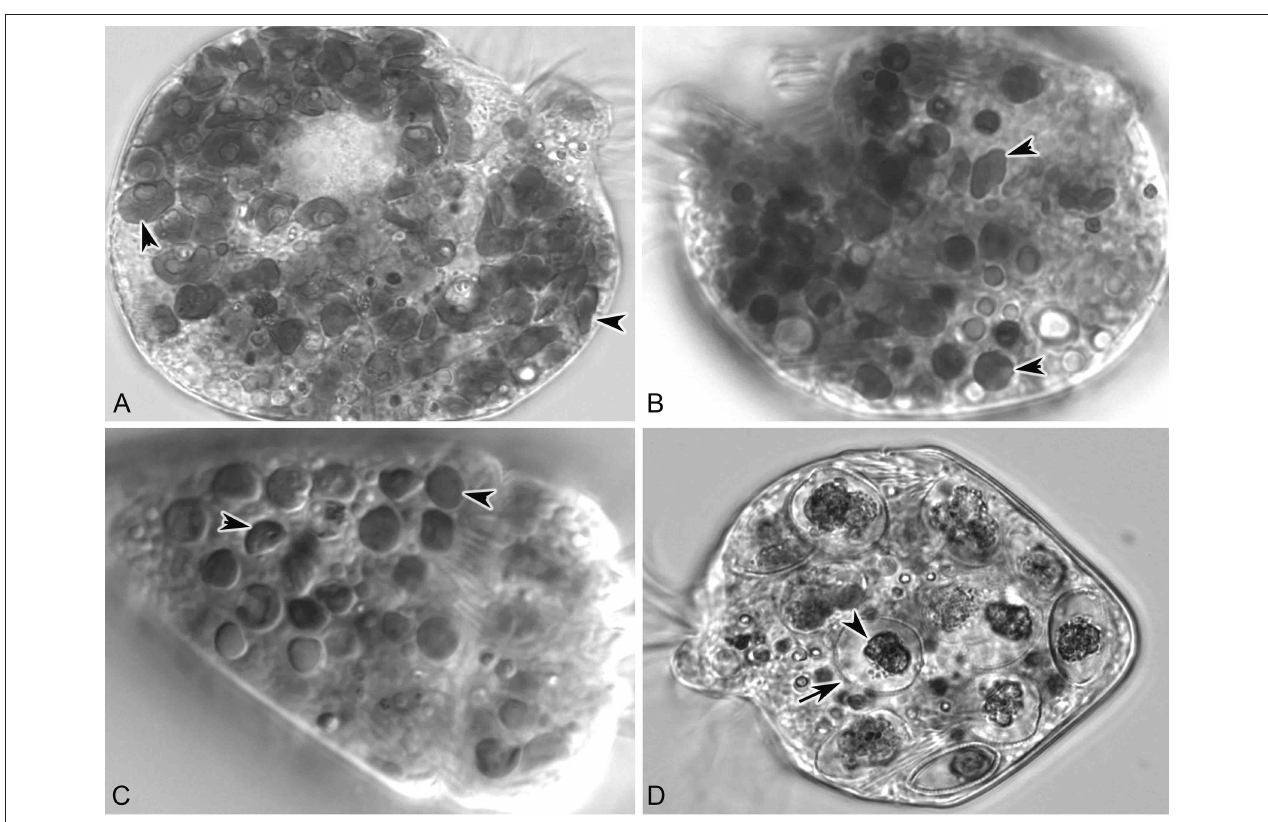
FIGURE 6 | S. rassoulzadegani fed four food algae that supported positive growth in the light (12:12 L:D). (A) S. rassoulzadegani fed T. chui PLY429; arrowheads indicate different shapes and sizes of retained chloroplasts; (B) S. rassoulzadegani fed R. lens RHODO; arrowheads as in A ; (C) S. rassoulzadegani fed Isochrysis sp. ISO SP; arrowheads as in A ; (D) S. rassoulzadegani fed P. minimum JA; note that no retained plastids appear in the cell. Arrow marks the rigid wall of the algal cell and arrowhead marks the partially-digested algal